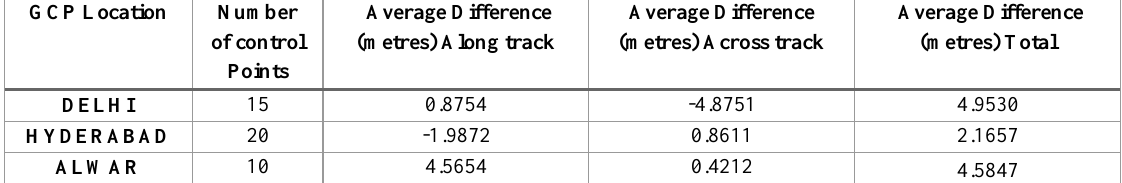
Table 3: RMSE calculation using ORTHO Reference